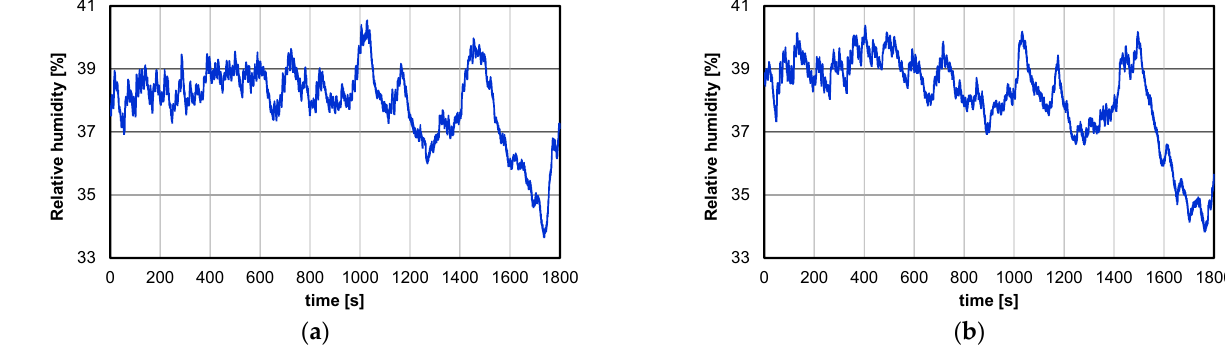
Figure 8. The relative humidity versus time for: ( a ) plug-in; ( b ) HEV.